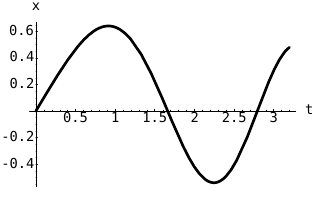
Figure 2. Solution of the prob- lem x ′′ +(1+3 sin t ) x = 0 , x (0) = 0 , x ′ (0) = 1